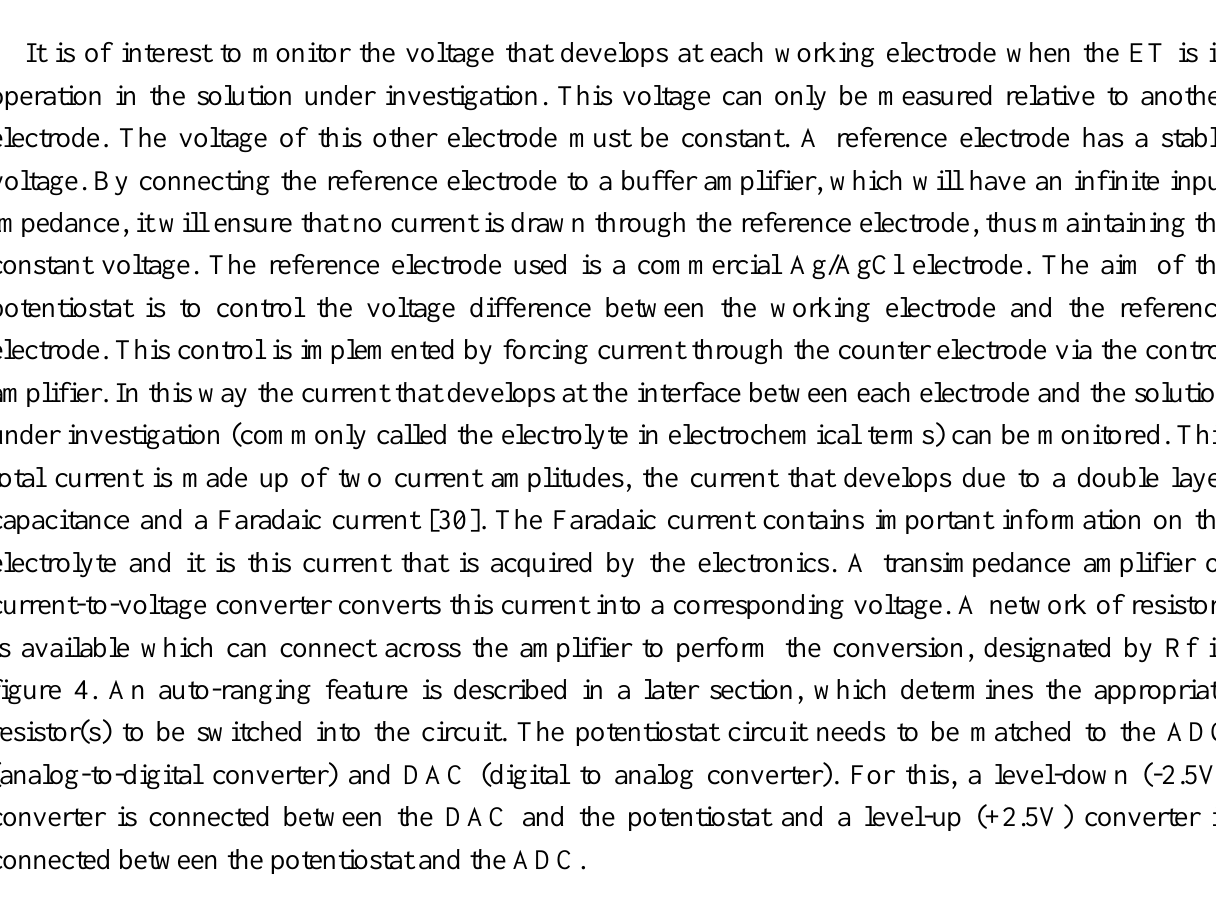
Figure 4. The potentiostat circuit with level-up and level-down converters shown, REF1 = REF2 = 2.5